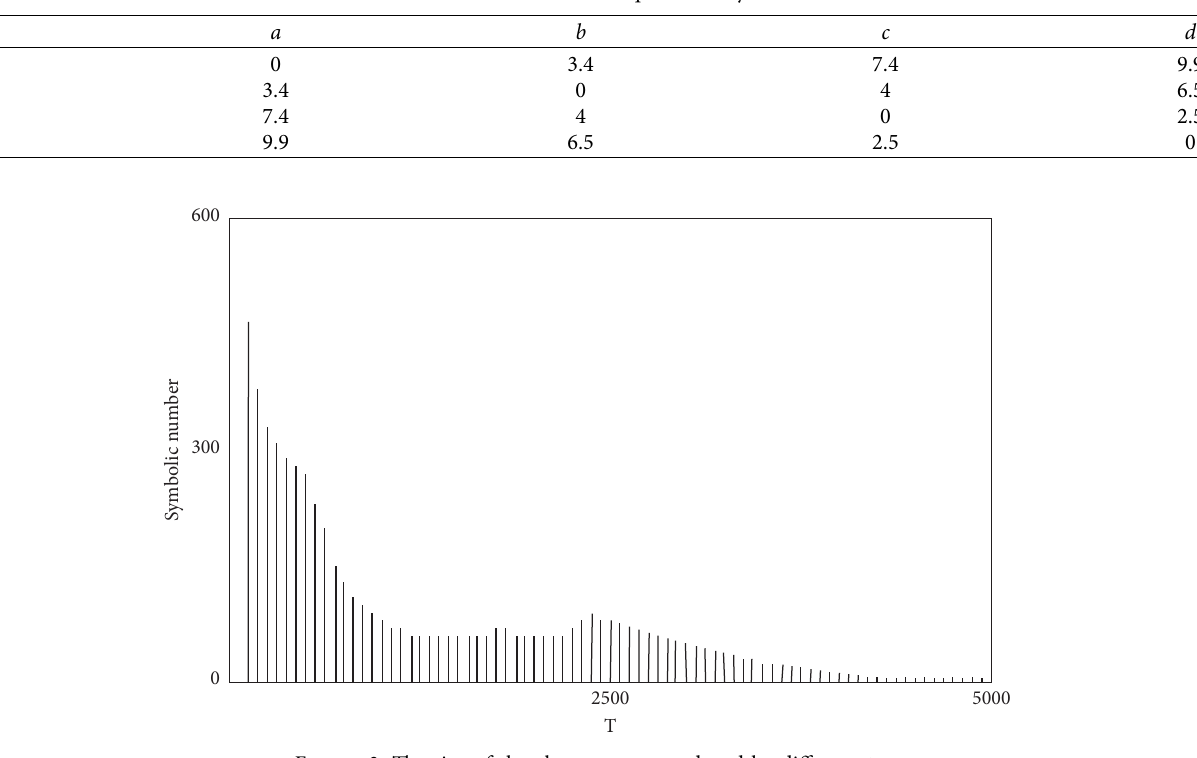
Table 2: Distance between equal-sized symbols.